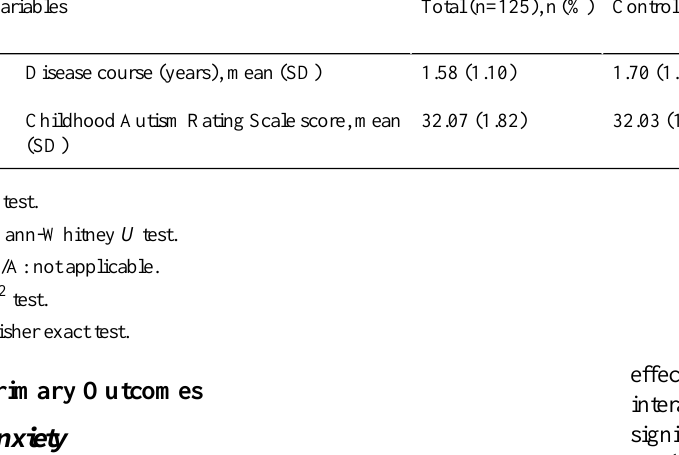
effect ( F =93.760, P <.001), and a significant group ×